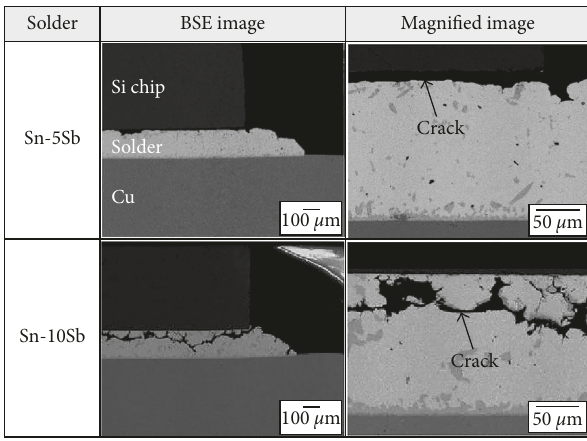
Figure 7: Back-scattered electron images of cross sections of solder joints after the power cycling test.